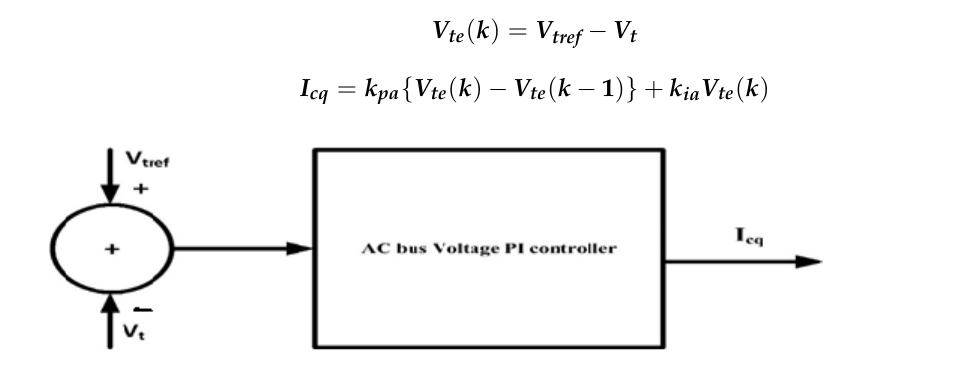
Figure 4. Design of I_cq.